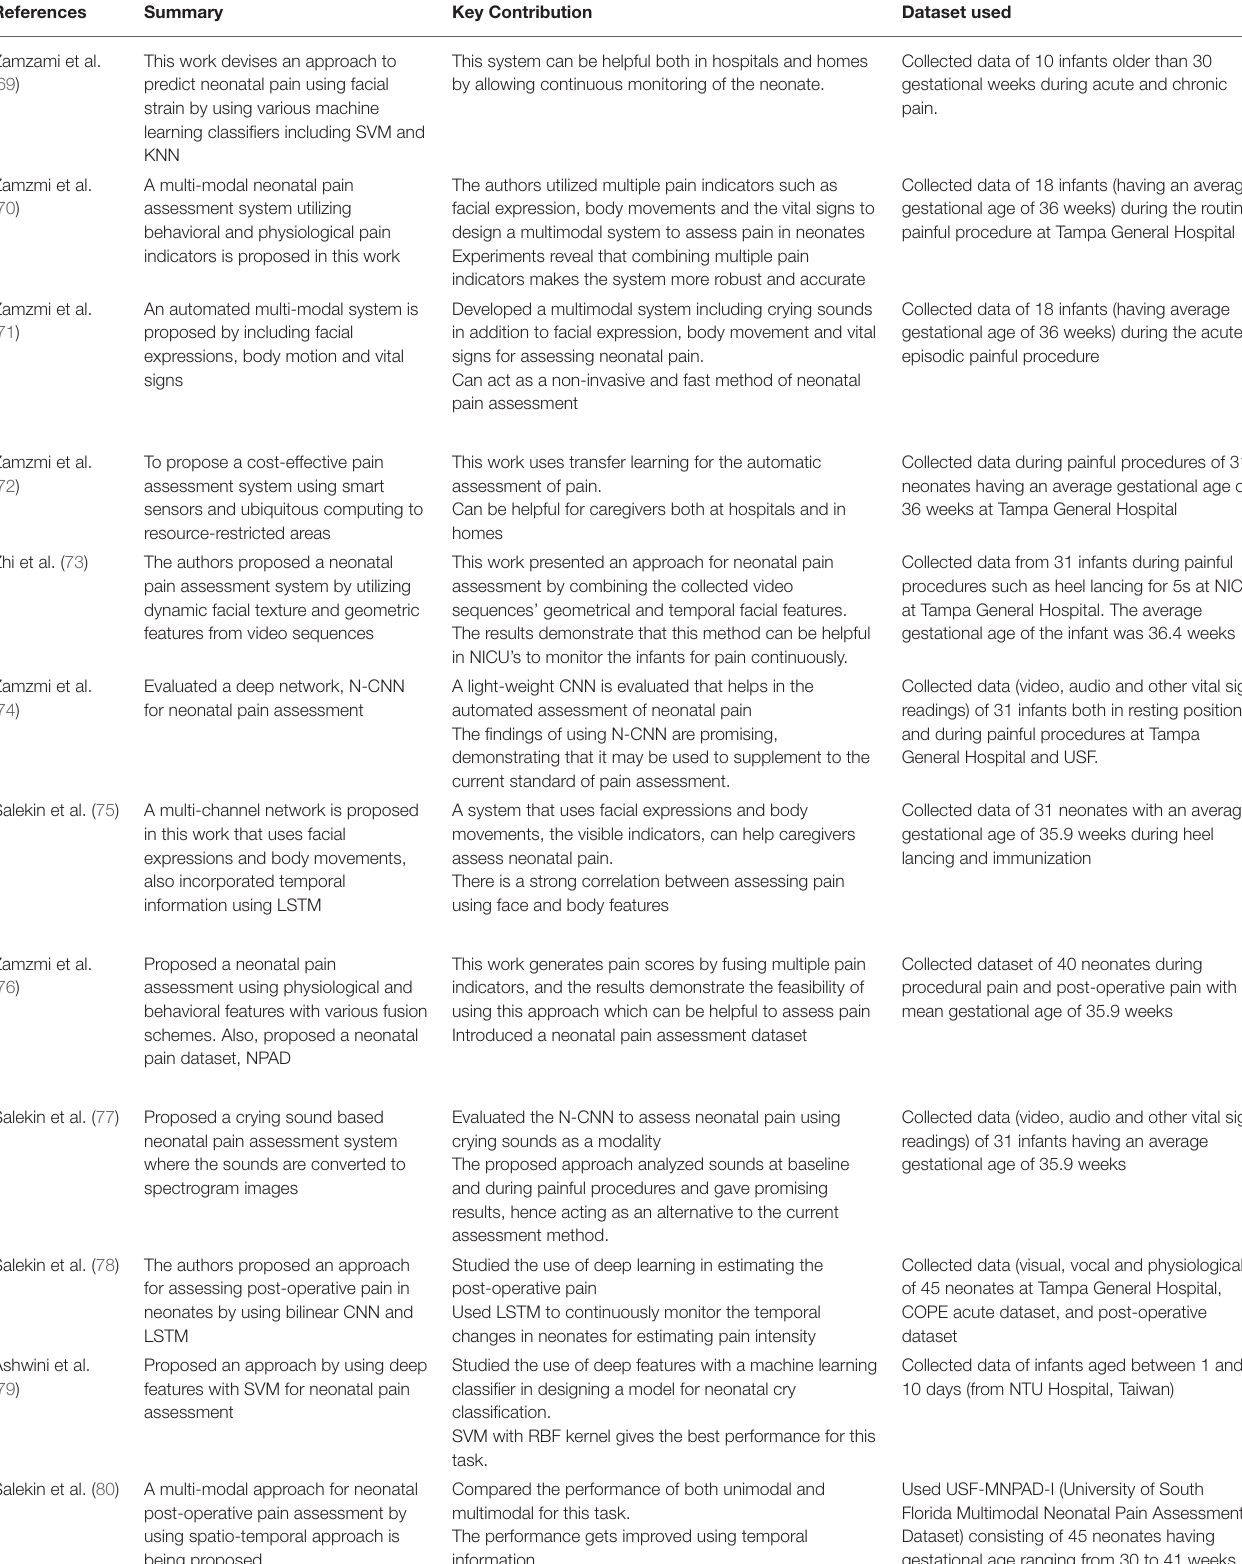
TABLE 8 | Summary of approaches used to predict neonatal pain using